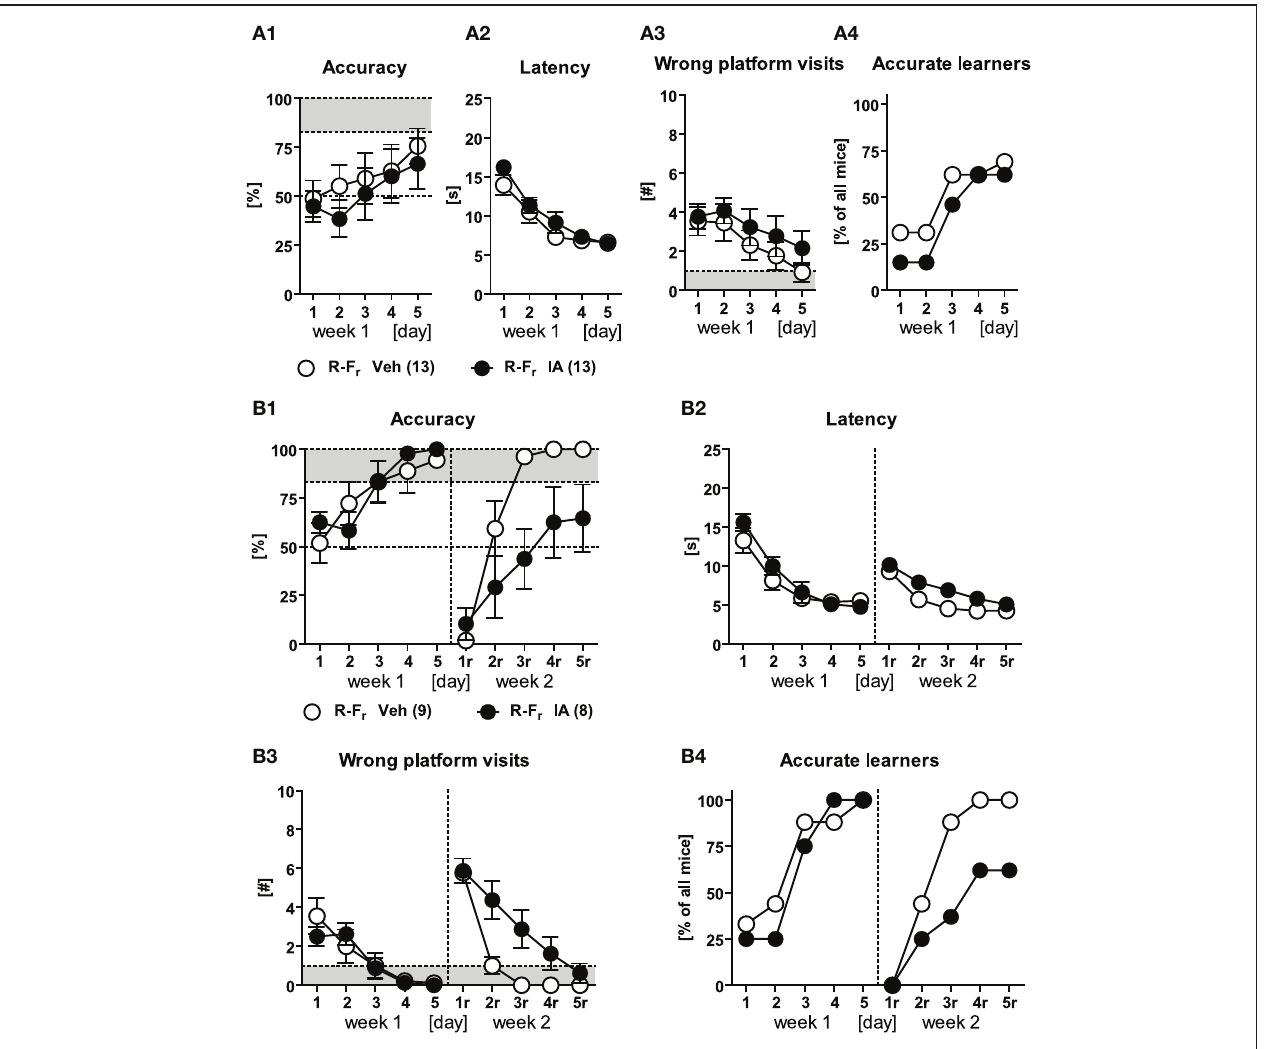
FIGURE 7 | Response learning and free choice relearning in HPC-lesioned animals. Veh and IA animals underwent response learning in the 1st week and free choice learning in the 2nd week (R-F r ). (A1–A4) Mice from both treatment groups performed equally well upon response training. However both groups failed to reach the accuracy criterion because 4/13Veh and 5/13 IA animals had adopted a “wrong” response indicated by accuracy levels below 17%. Therefore, we additionally cleared the data from these animals and re-examined training